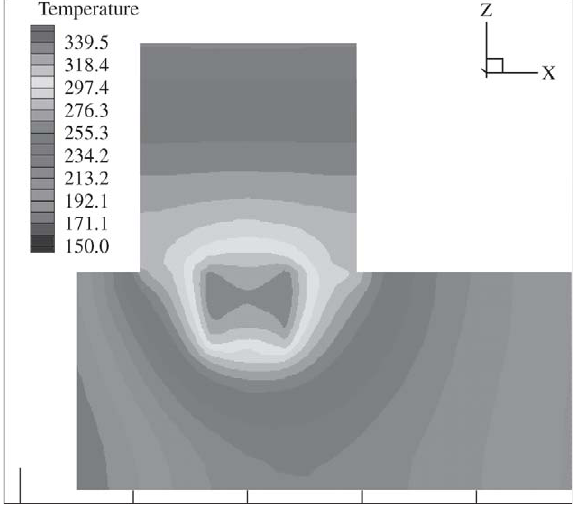
Figure 6. Temperatures field in planes XZ and YZ respectively.